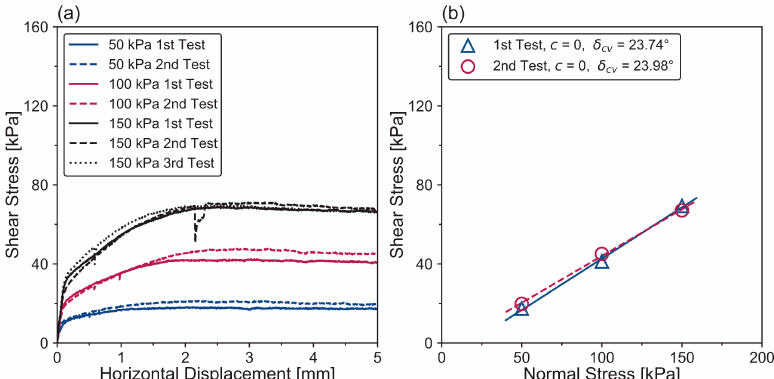
Figure 11. Repeatability of the interface direct shear test on S1 sand–clay mixture samples of 75% clay content: ( a ) shear stress as a function of horizontal displacement and ( b ) Mohr–Coulomb envelope, critical adhesion and interface friction angles of the 1st and 2nd